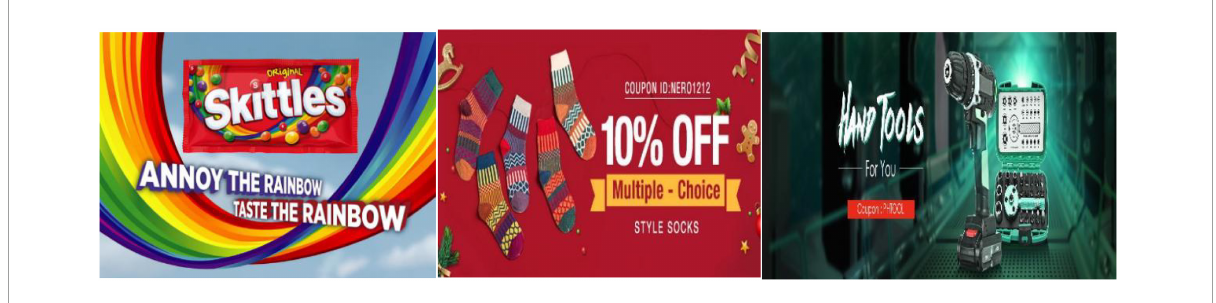
FIGURE3 The common online advertisings (OAs).